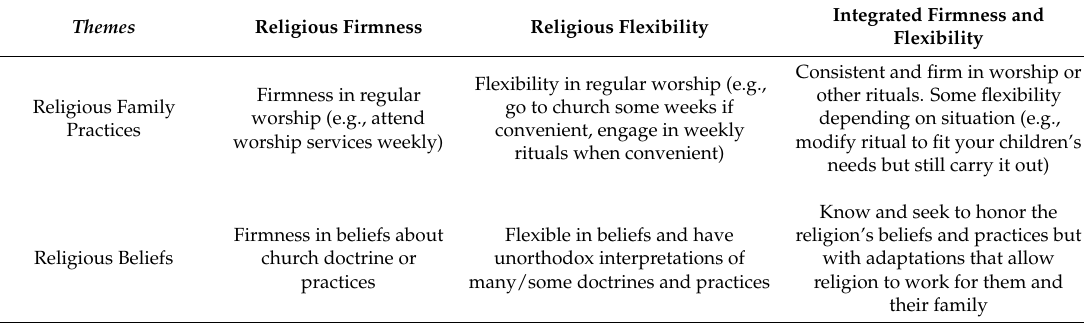
Table 1. Concepts: Firmness and Flexibility in Religious Practices and Religious Beliefs.